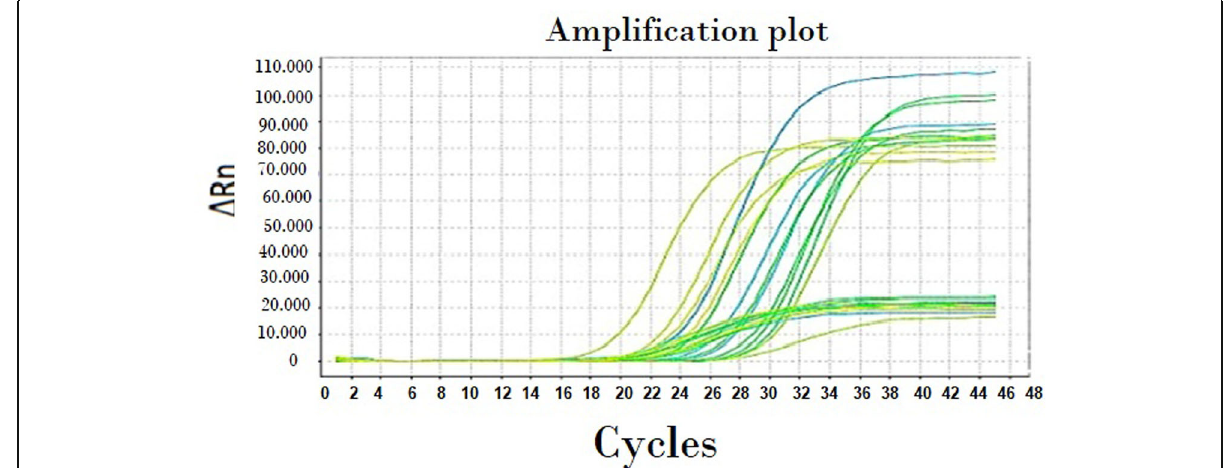
Fig. 2 DNMT3A mRNA expressions in patient and control groups by